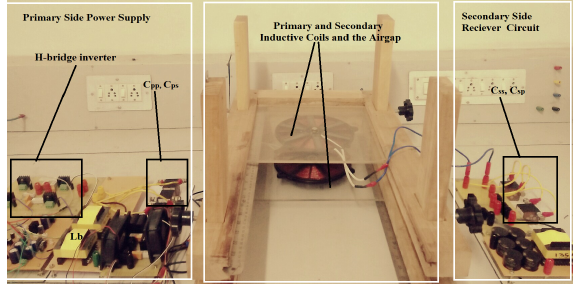
Figure 17. Experimental prototype of LCL